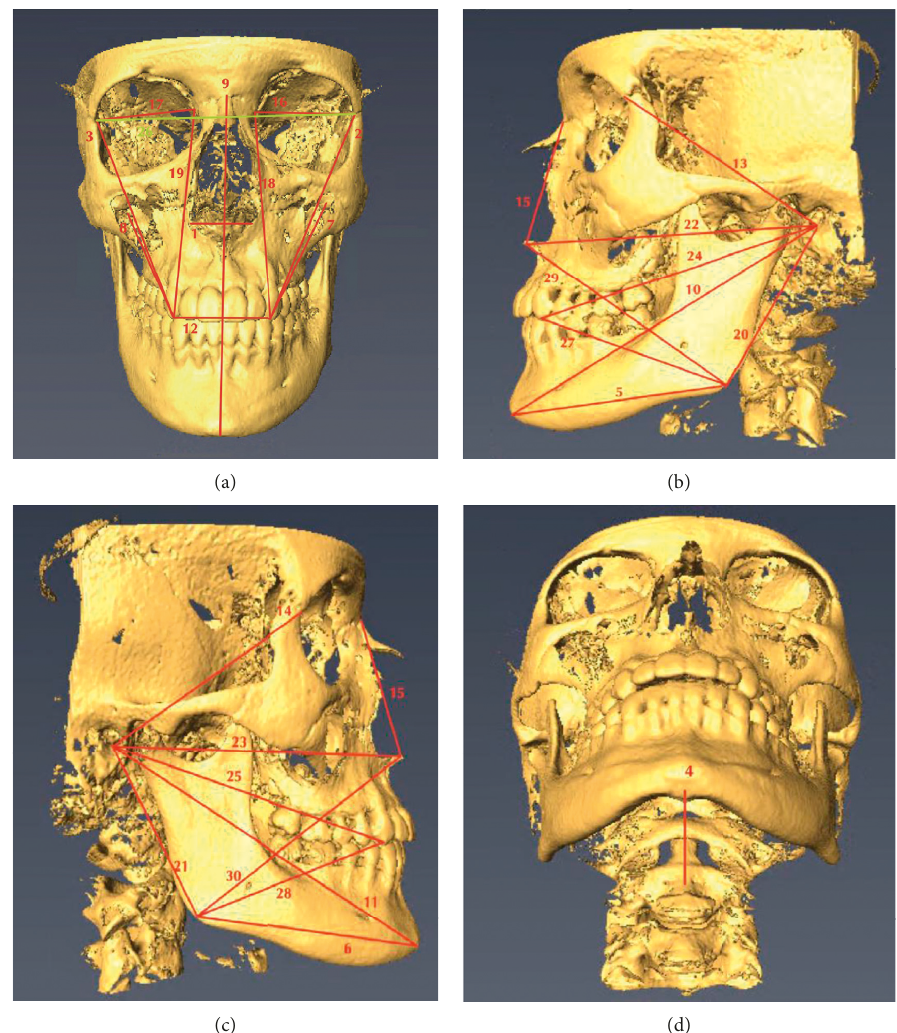
Figure 1: Front, left lateral profile, right lateral profile, and inferior views of the CBCT image, with numbered areas corresponding to landmarks. (a) Frontal view. (b) Left lateral profile view. (c) Right lateral profile view. (d) Inferior